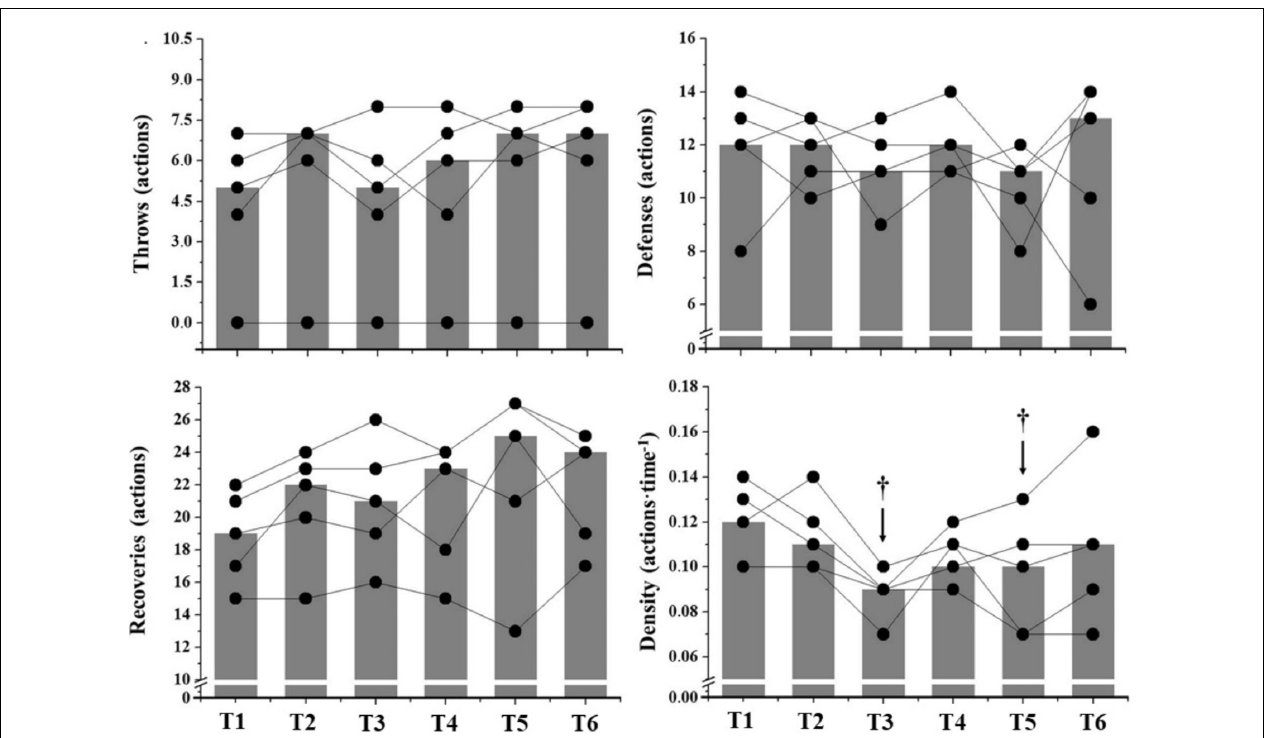
FIGURE 4 | Individual responses of GTP observed at the specific measurements moments (T0–T6) throughout the simulated game. Gray bars represent median values at each assessment moment. † Significant differences from